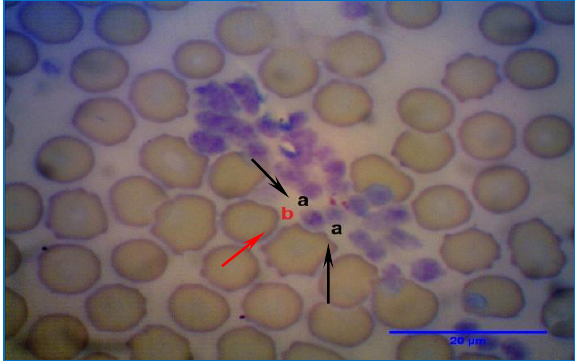
Figure, 9: (a) Large-sized lymphocyte, (b) Blood Platelet, (c) Artifact (100x × 1.3 megapixels).